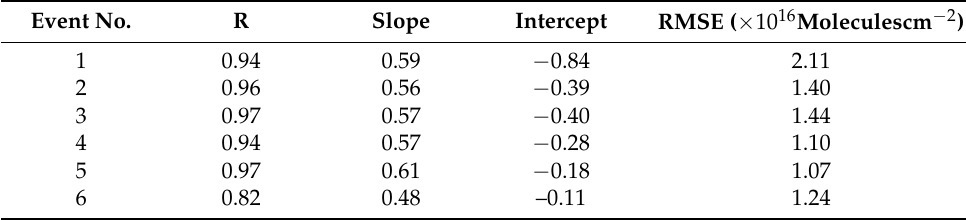
Figure 11. Correlations between true SO 2 VCDs and those retrieved for each event in Table 1. Table 2. Correlation between SO 2 VCD True and SO 2 VCD Retrieved